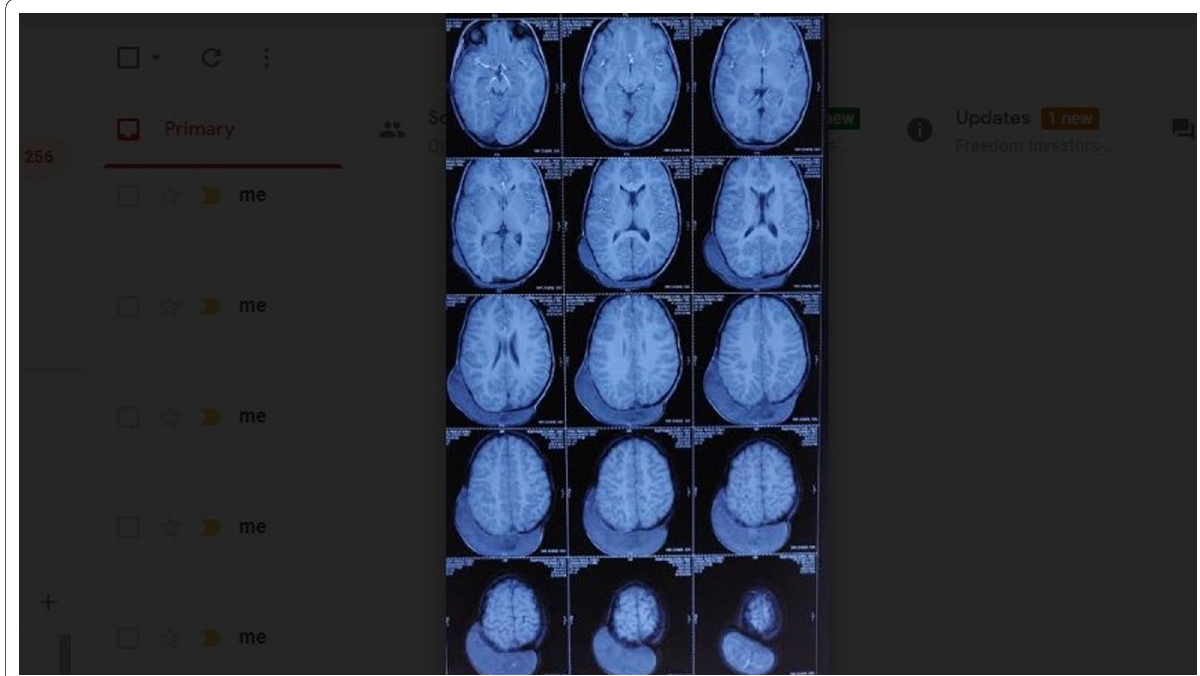
Fig. 2 T1-weighted axial non-contrast images show a large heterogeneously hyperintense swelling over bilateral parieto-occipital region of the scalp suggesting